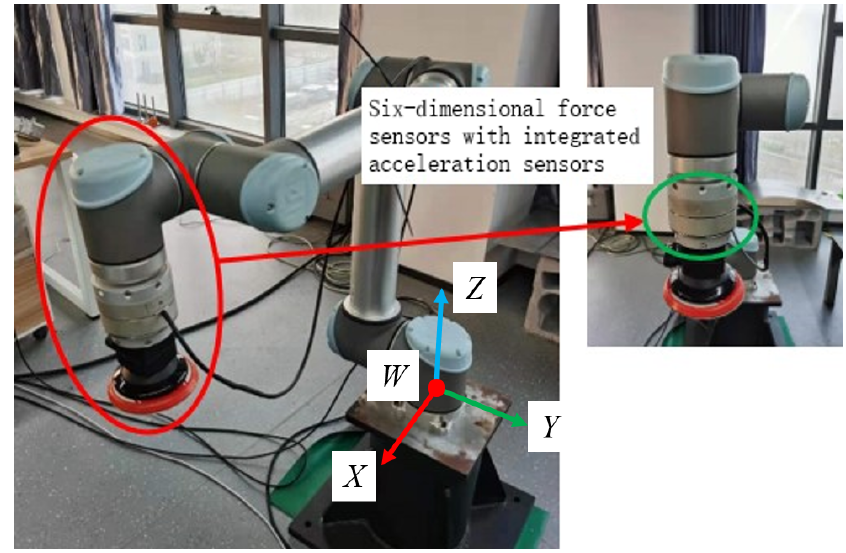
Figure 4. Physical test scene diagram.